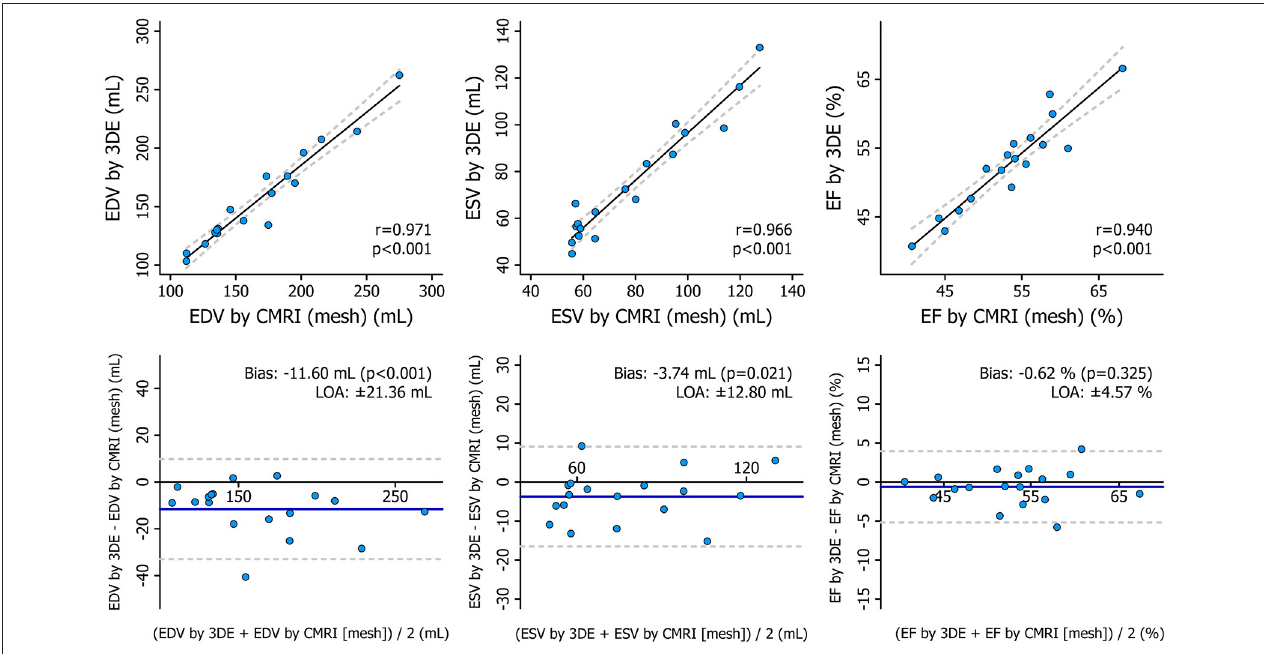
FIGURE 8 | Correlation and agreement between 3D echocardiography- and cardiac magnetic resonance imaging-derived measurements of right ventricular end-diastolic volume, end-systolic volume, and ejection fraction depicted by correlation and Bland–Altman plots. The correlations between 3D echocardiography-derived measurements and the corresponding cardiac magnetic resonance imaging-derived values were quantified using Pearson correlation coefficients, and Bland–Altman analyses were performed to assess the bias and limits of agreement. Paired Wilcoxon signed-rank test vs. null values was applied to test the significance of the bias. 3DE, 3D echocardiography; CMRI, cardiac magnetic resonance imaging; EDV, end-diastolic volume; EF, ejection fraction; ESV, end-systolic volume; LOA, limits of agreement.